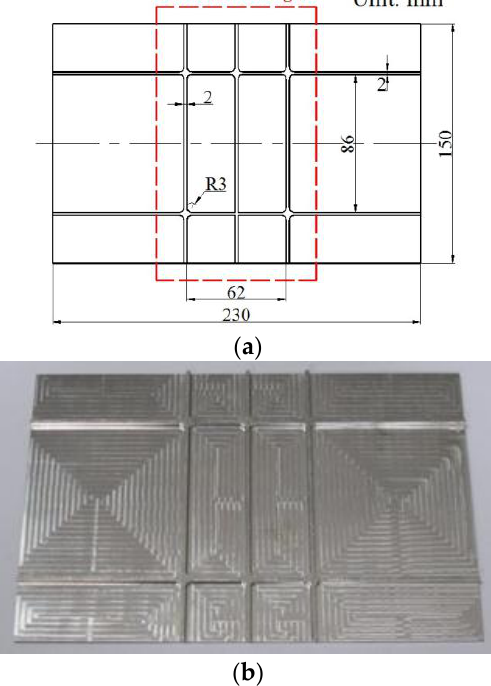
Figure 2. The grid-rib panel: sizes ( a ); and the experimental blank sample ( b ).